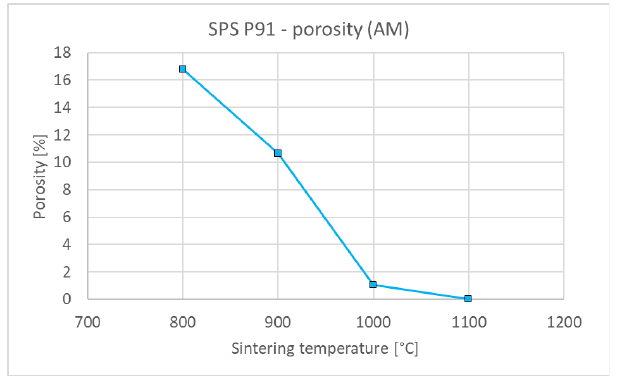
Figure 6. Microstructures of the steel compacts (central regions) sintered at ( a ) 800 °C, ( b ) 900 °C, ( c ) 1000 °C, ( d ) 1100 °C.